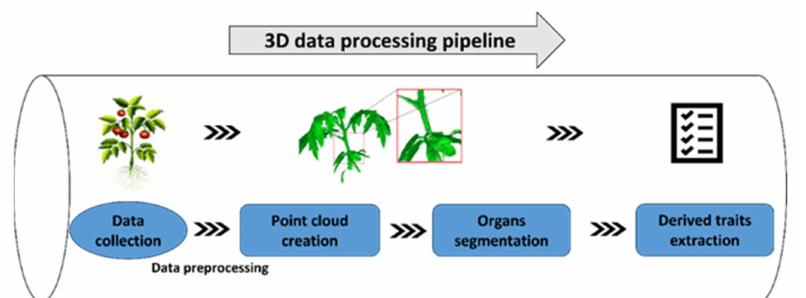
Figure 5. Three-dimensional phenotyping data processing pipeline. Data processing flow includes: data collection, data preprocessing, point cloud creation and organ segmentation, and derived traits